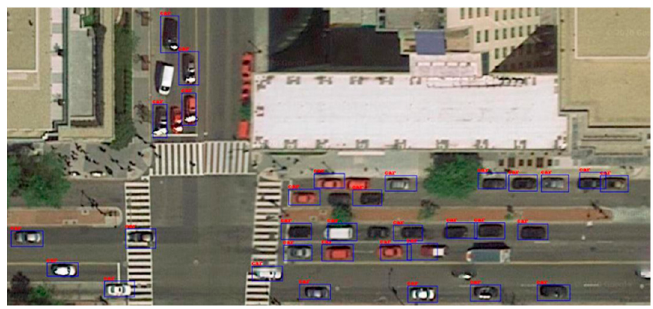
Figure 19. The detection result of a fuzzy remote sensing image in Washington.